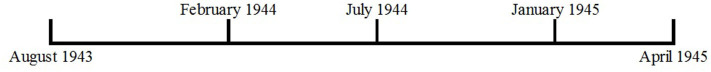
Timeline existence of the Mittelbau-Dora concentration camp and examined months of patients with tuberculosis.